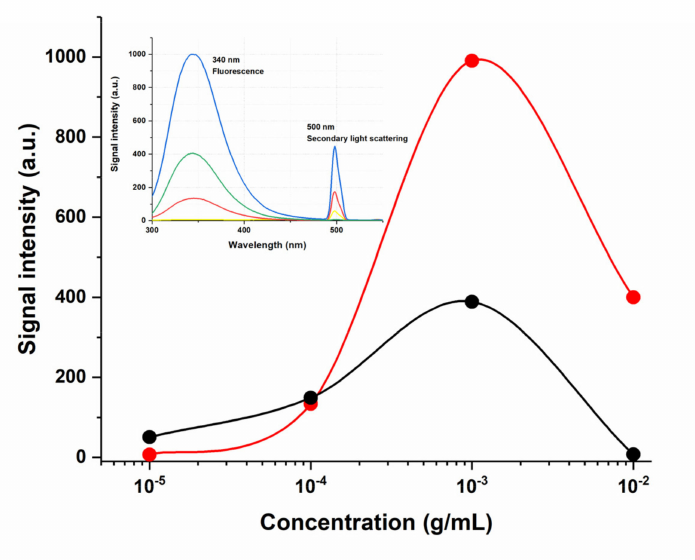
Figure 6. Dependence of the fluorescence signal at 340 nm (red line) and the second-order scatter- ing signal at 500 nm (black line) depending on the concentration of BSA in an aqueous solution, λ ex = 250 nm; the fluorescence spectra of the BSA dilutions are shown in the insert: yellow–10 − 5 , red–10 − 4 , blue–10 − 3 , green–10 − 2 , g/mL, λ ex =